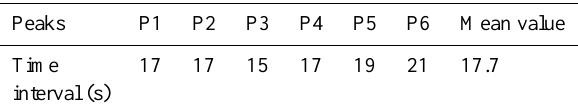
Table 2. Time intervals between the appearance of corresponding peaks in the two hydrographs recorded at the geophones G1 and G2 (Fig. 4).